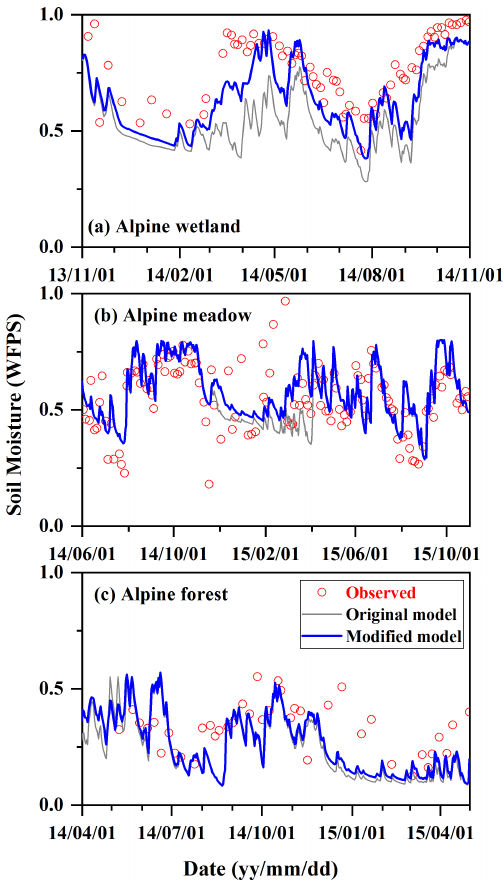
Figure 2. Observed and simulated daily topsoil (0–6cm) moisture in the water-filled pore space (WFPS) from the alpine wetlands, meadows and forests by the original and modified models. The leg- end in panel (c) applies for all